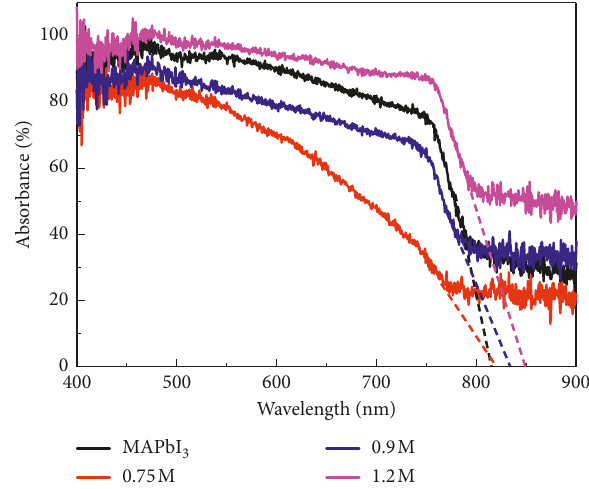
Figure 4: UV-visible absorption spectra of perovskite films with